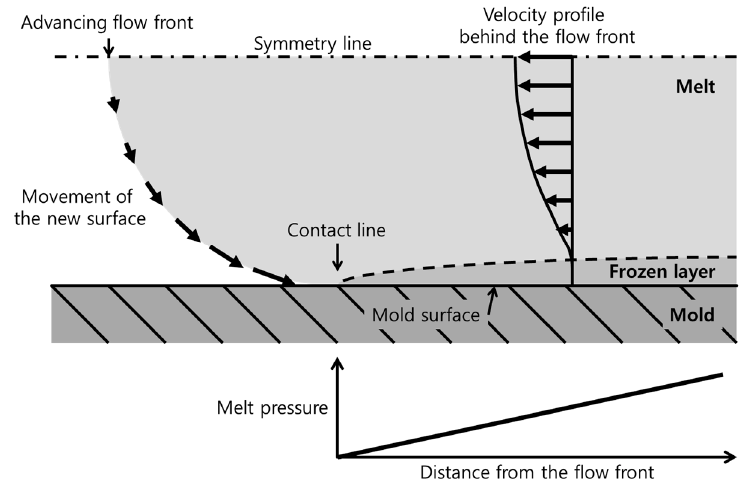
Figure 10. Fountain flow and melt pressure development at the flow front.